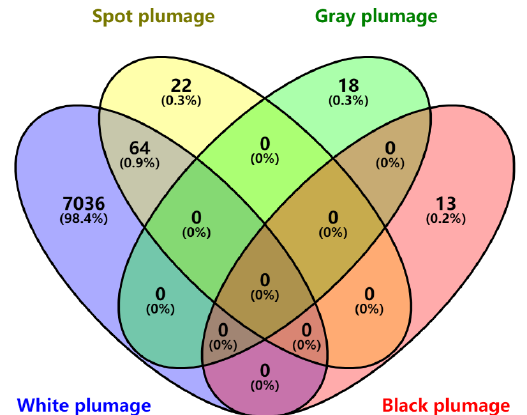
Figure 5. Venn analysis of significant and potential SNPs of four-color plumage